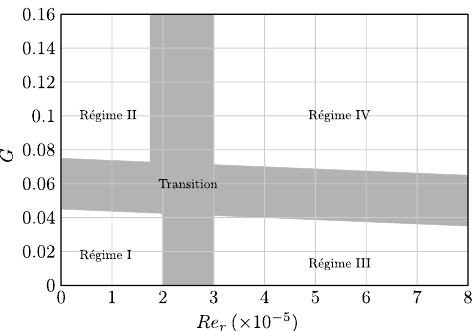
Figure 1. Heat transfer regimes for an open discoidal rotor-stator system (Reprinted from [14] with permission from Elsevier): regime I (laminar, merged boundary layers), regime II (laminar, separated boundary layers), regime III (turbulent, merged boundary layers), and regime IV (turbulent, separated boundary